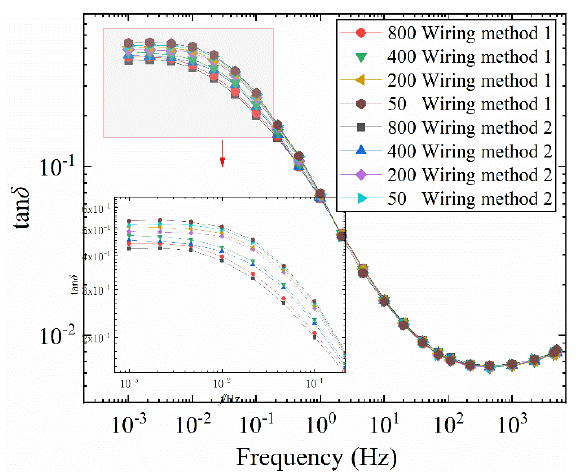
Figure 13. Influence of different wiring methods on tan δ - f curve of bushing model at different voltages (30 °C).